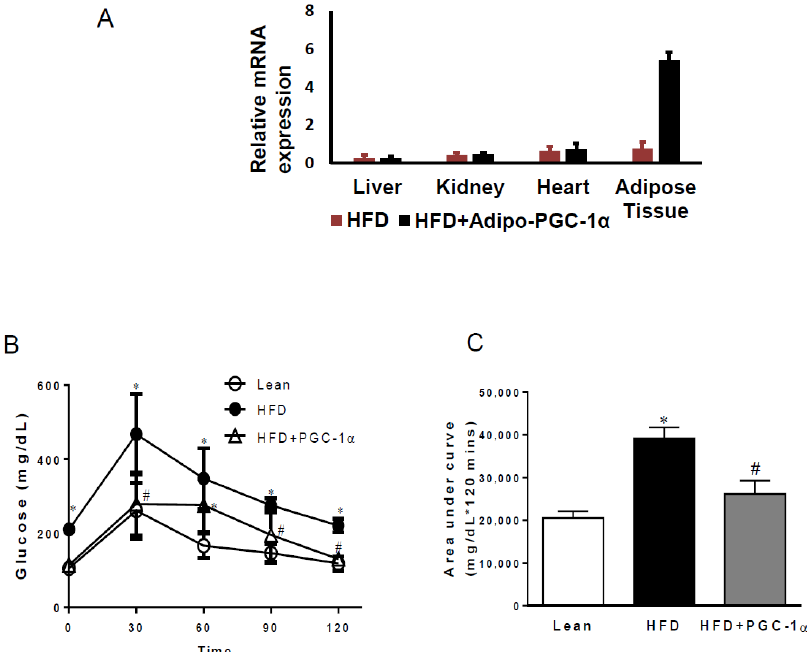
Figure 1. Effects of the adipocyte-specific overexpression of PGC-1 α in high-fat-diet (HFD.)-fed mice. ( A ) Tissue expression levels of adipo-PGC1 α ; ( B ) glucose tolerance test; and ( C ) area under curve; (data are expressed as mean ± SEM ( n = 5); * p < 0.05 versus lean; # p < 0.05 vs.HFD.